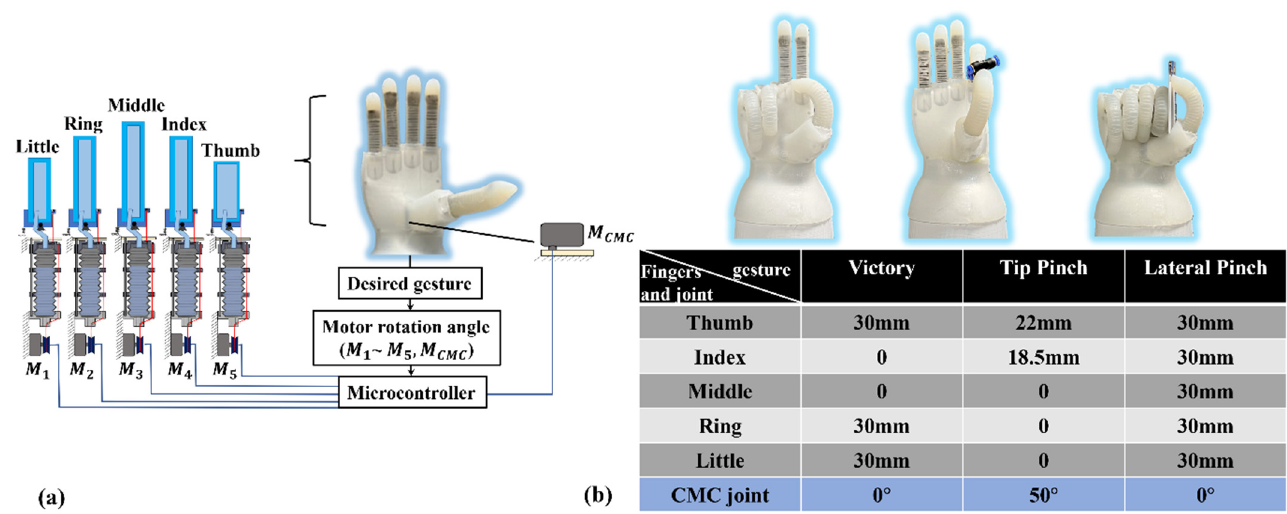
Figure 10. Actuation of the soft robotic hand. ( a ) Actuation strategy. ( b ) Three different hand gestures with related compressed bellow displacement of the CBA module and CMC joint rotation angle.